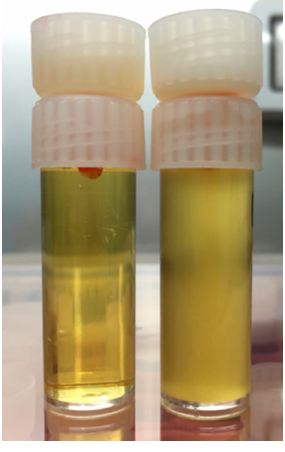
Figure 2. BHI medium in clear (left) and turbid states (right).